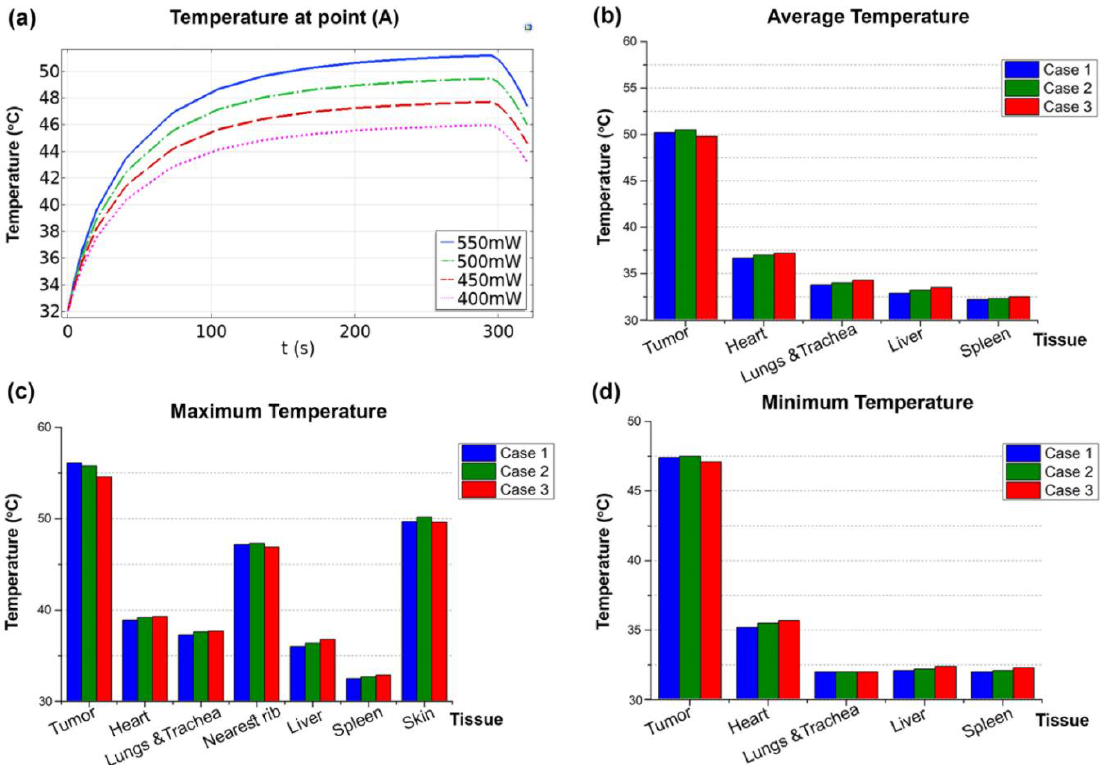
Figure 4. ( a ) Parametric study of the temperature rise in point (A) versus laser power and irradiation time. The 48 °C threshold is fully (or nearly fully) achieved for three combinations: Case 1 (blue): 550 mW and 90 s, Case 2 (green): 500 mW and 140 s and Case 3 (red): 450 mW and 295 s. For these cases the average ( b ), maximum ( c ) and minimum ( d ) temperature in the tumor and in healthy tissues are calculated.